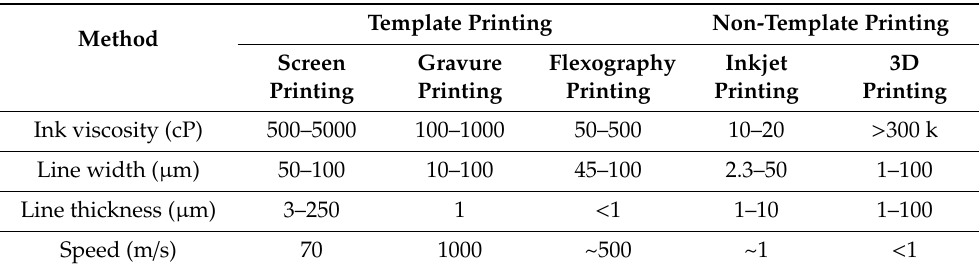
Table 3. Comparison of representative printing approaches for electrochemical